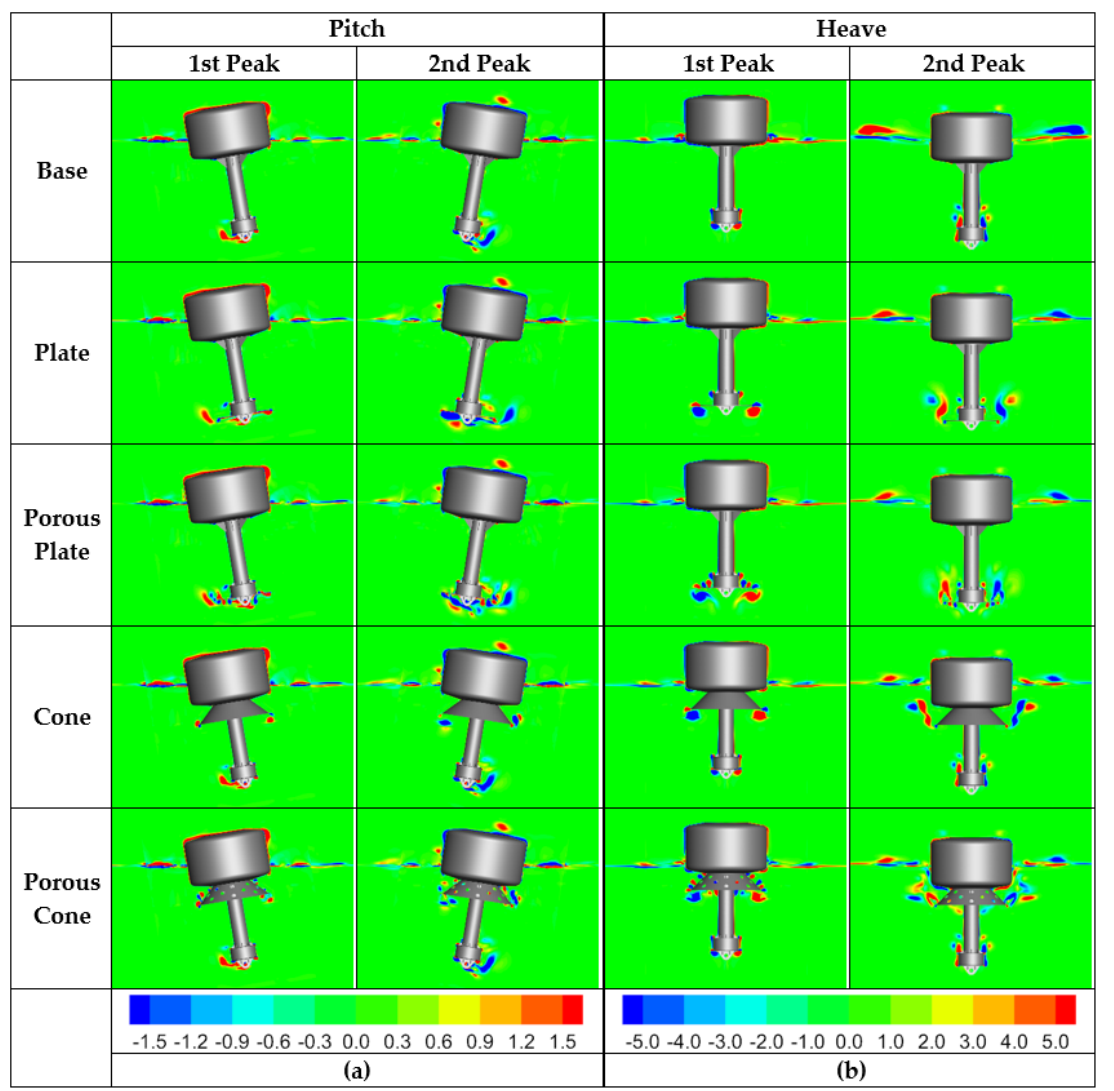
Figure 11. Comparisons of vorticity (j) distributions around the lightweight light buoys during ( a ) free pitch and ( b ) heave decay tests when the first and second peaks of motion occur.